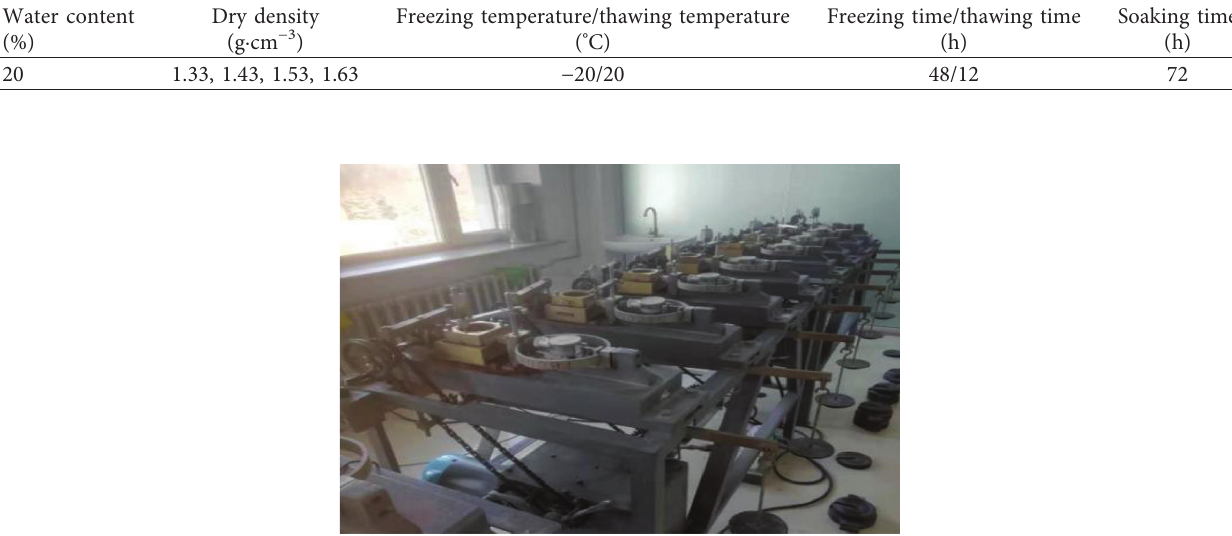
Figure 3: Electric strain direct shear